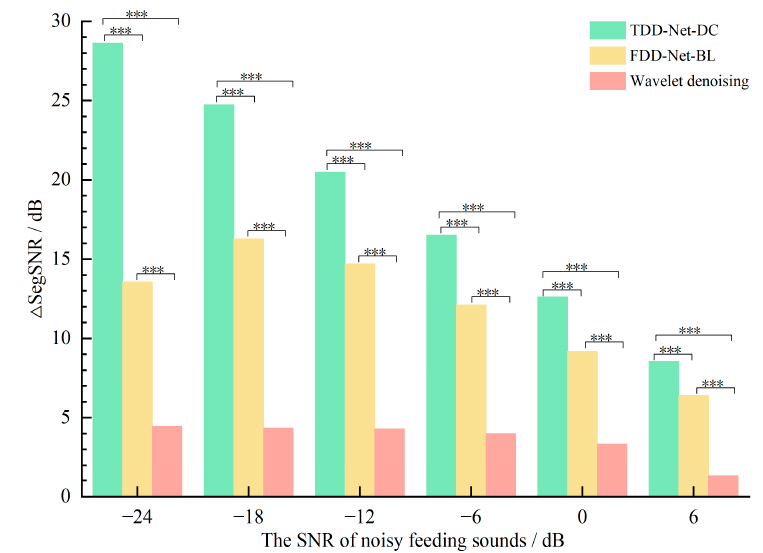
Figure 7. Comparison of the ∆ SegSNRs of different denoising methods at different SNRs, *** means highly significant ( p ≤ 0.001).